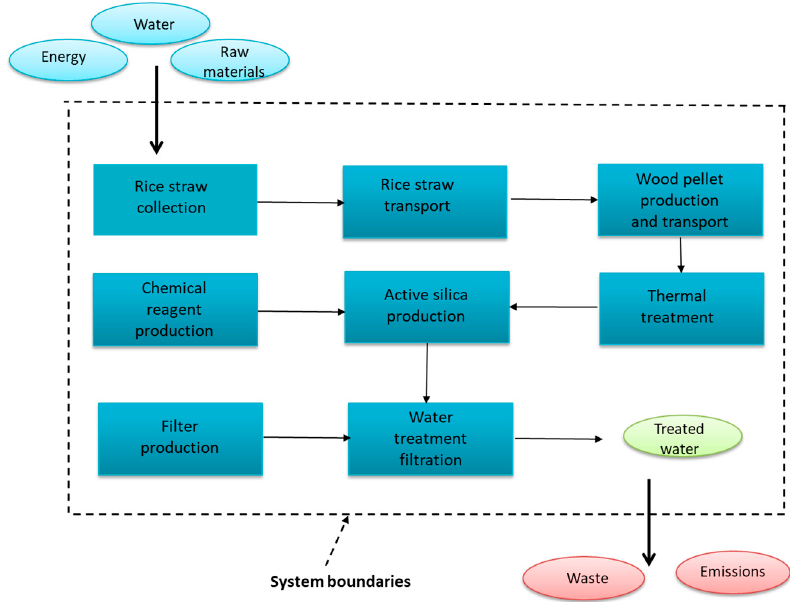
Figure 2. System boundaries of water-treatment process by active silica.